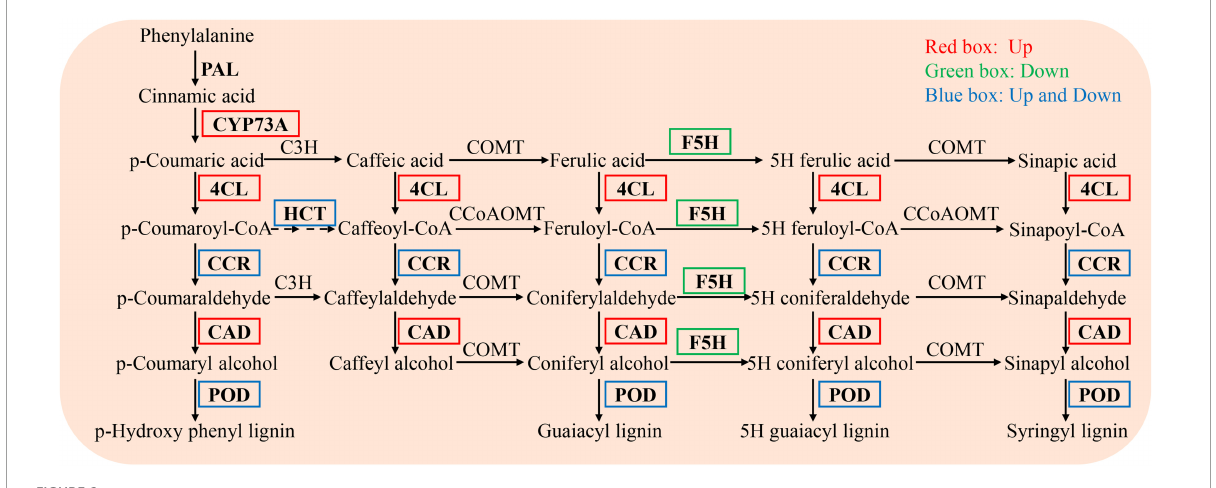
FIGURE6 DEGs enriched in the phenylpropanoid biosynthesis pathway in the NaCl vs WR10 + NaCl. NaCl, with NaCl and without WR10; WR10 + NaCl, with NaCl and WR10. Red boxes, significantly up-regulated genes; Green boxes, significantly down-regulated genes; Blue boxes, significantly up- and downregulated